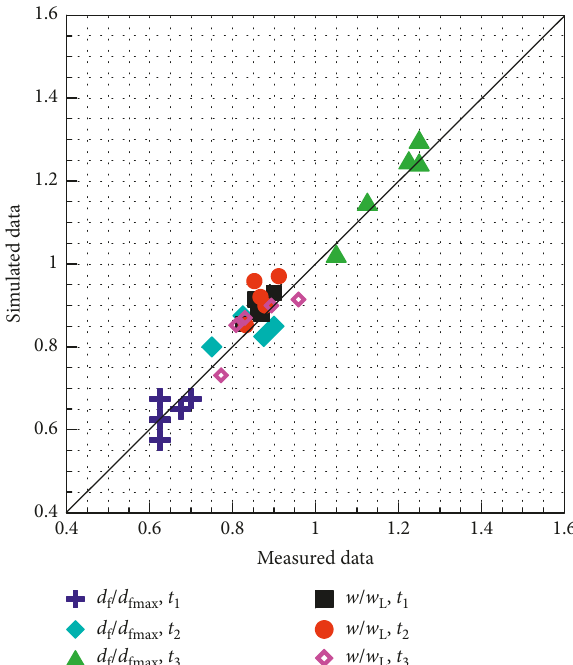
Figure 14: Comparison of calculated frozen depth and water content and measured data.